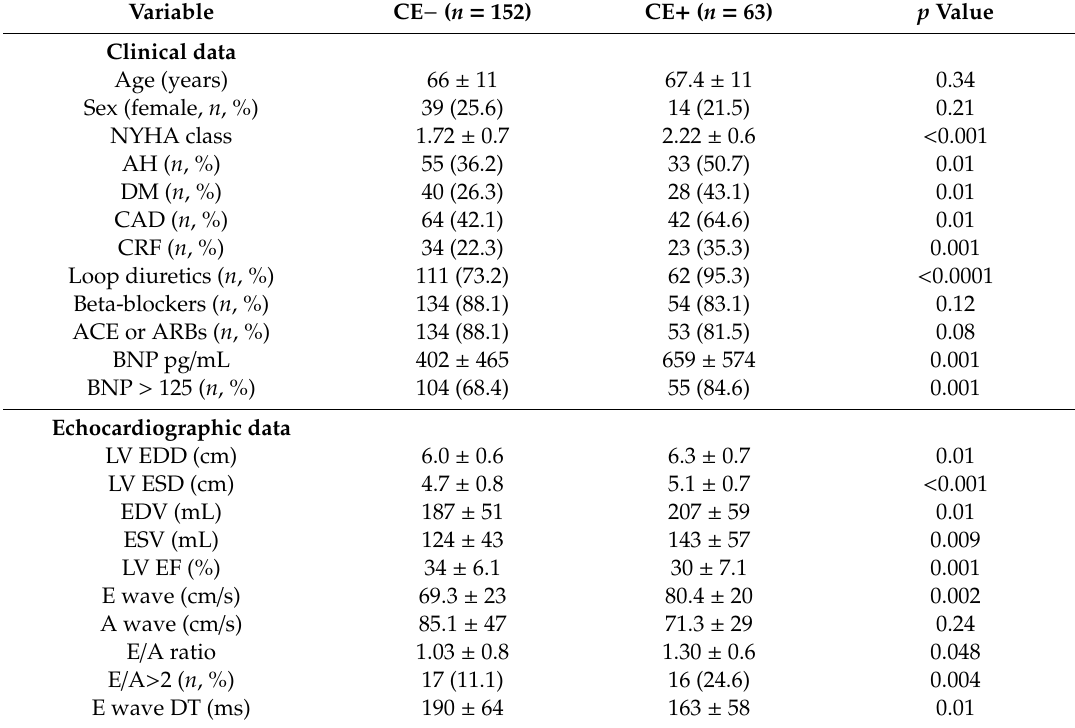
Table 1. Baseline clinical, demographic and echocardiographic characteristics of the study